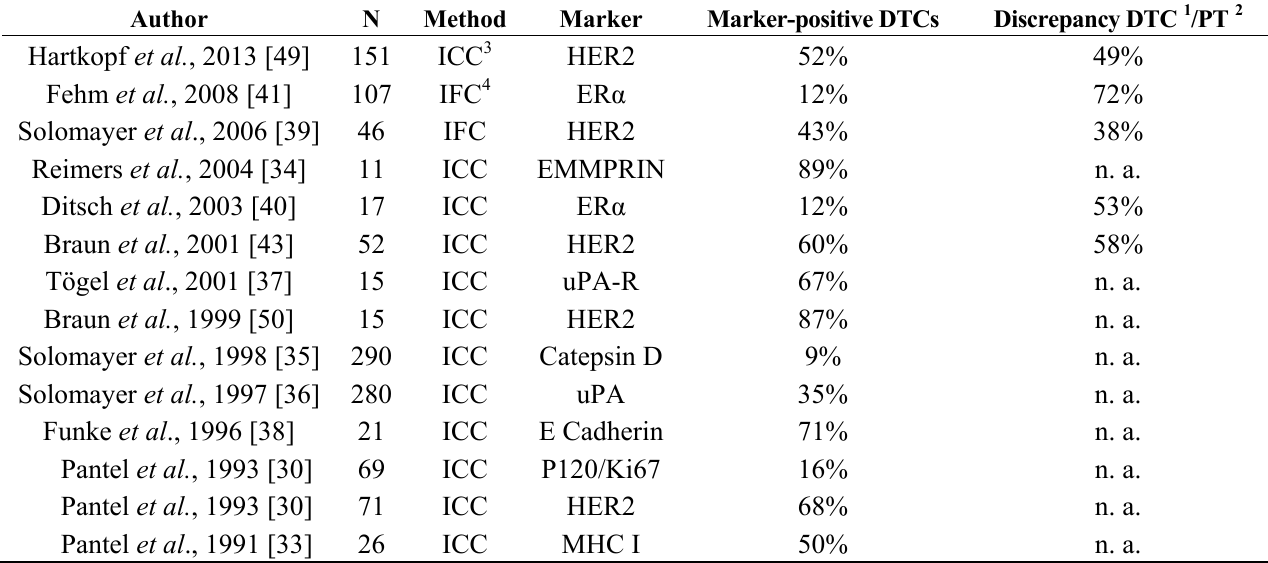
Table 1. Expression profiles of DTCs in primary breast cancer